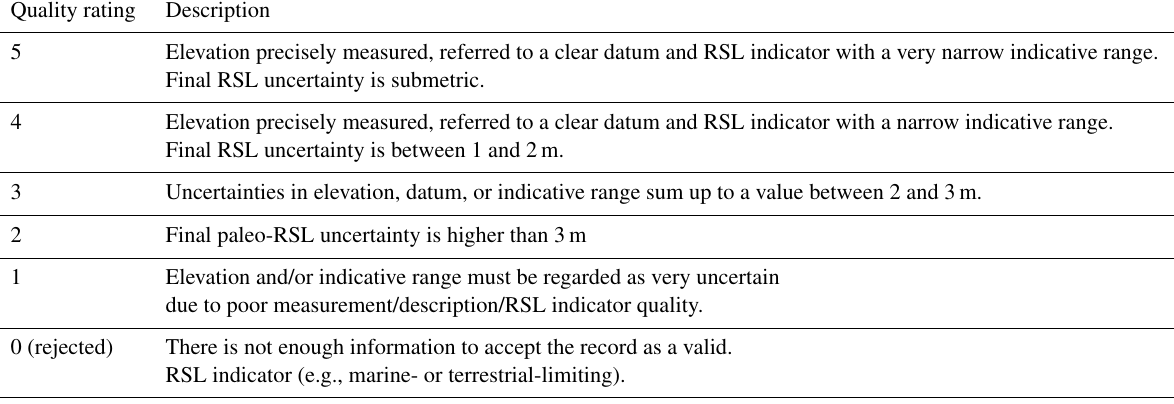
Table 1. Quality assessment of the relative sea-level data in terms of vertical uncertainty, as defined in the WALIS database documentation: